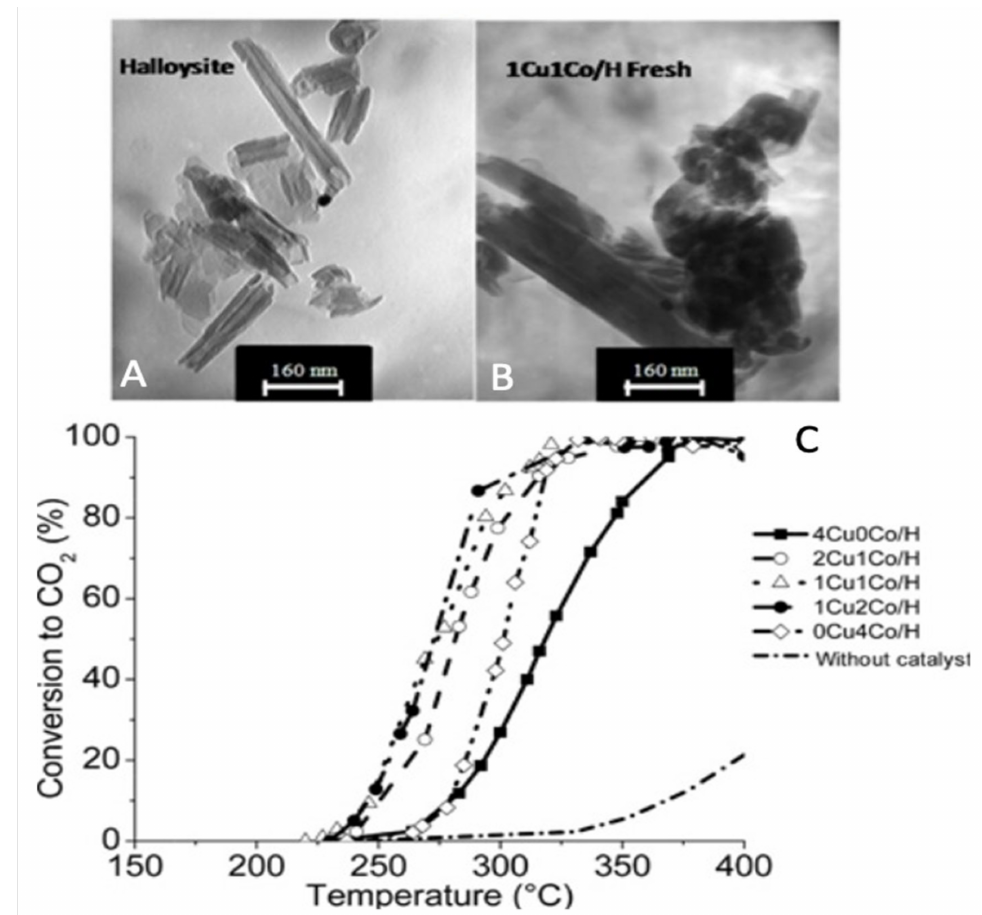
Figure 11. Structural stability assessment of the support and the (20 wt%) 1Cu1Co/HNT catalyst. ( A ) Nanotubes observed via TEM before and after catalyst synthesis ( B ). ( C ) XRD evidence after synthesis and a catalytic test. Reprinted with permission from Ref. [102]. Elsevier,